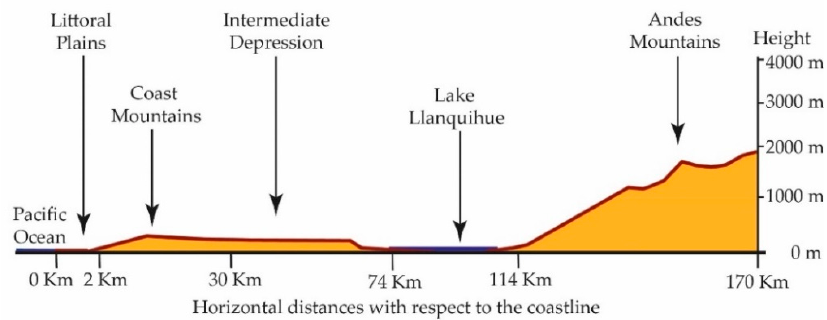
Figure 3. Topographic profile 41° Latitude South of Chile.